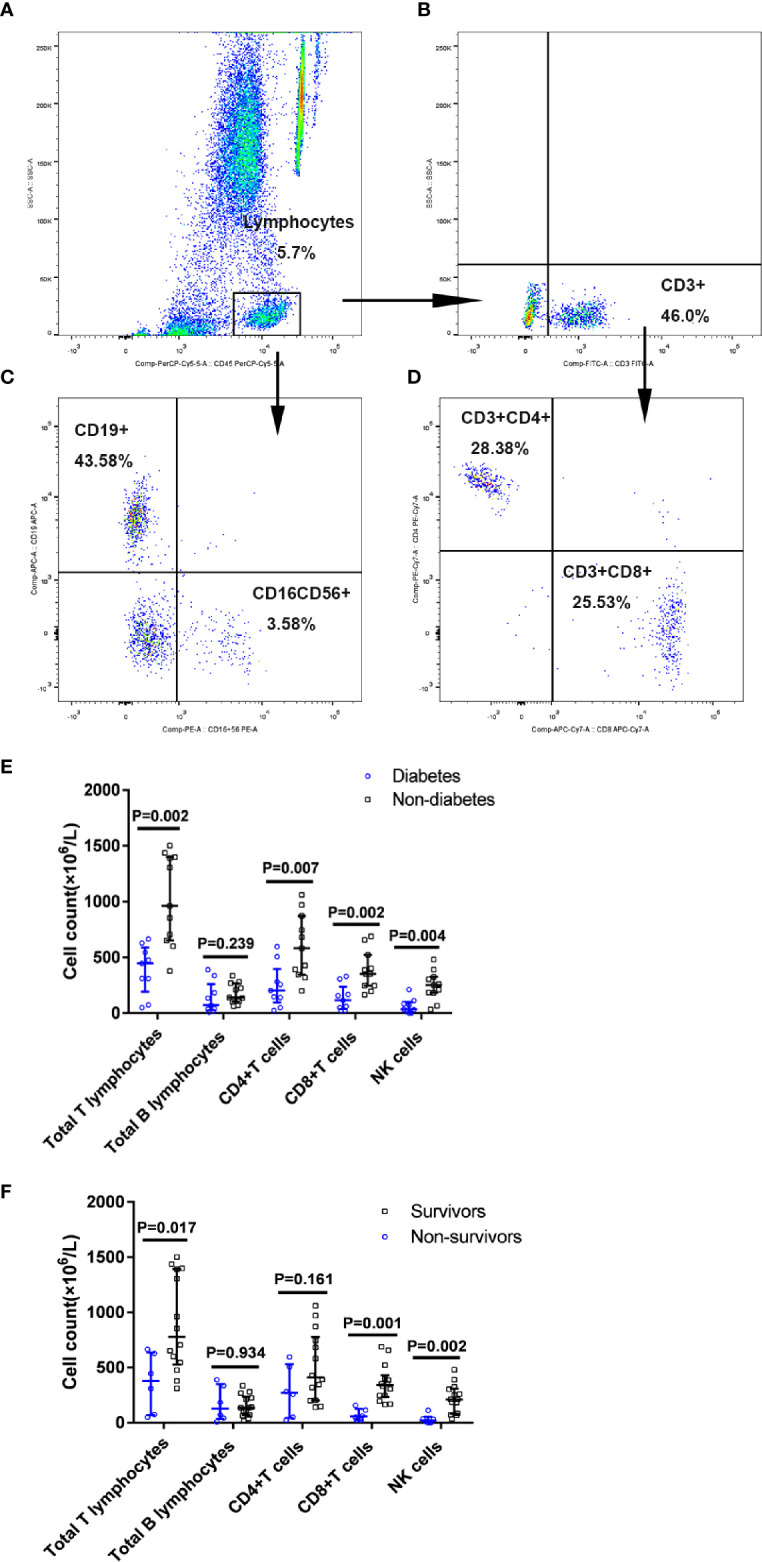
Proportion of immune cells subsets in patients with diabetes with COVID-19. Flow cytometric analysis of B cells, NK cells, CD4+ T cells, and CD8+ T cells from a representative patient (A–D). A series of comparisons of absolute counts of total T and B lymphocytes, CD4+ T cells, CD8+ T cells, and NK cells between patients with diabetes (n=9) and patients without diabetes (n=11) (E), as well as between survivors (n=14) and non-survivors (n=6) (F). All data represent median (IQR). Differences were tested using nonparametric test.